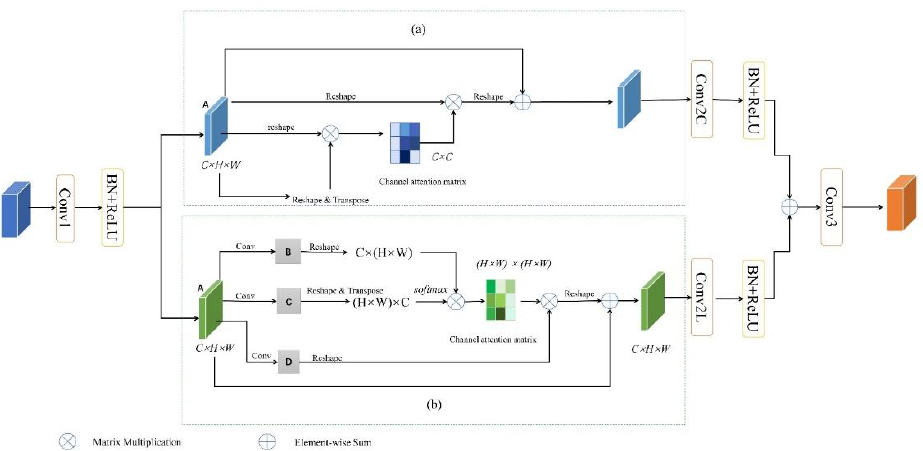
Figure 5. The architecture of the dual attention module consists of two branches: the kernel attention module and channel attention module. ( a ) Kernel attention module, and ( b ) channel attention module.